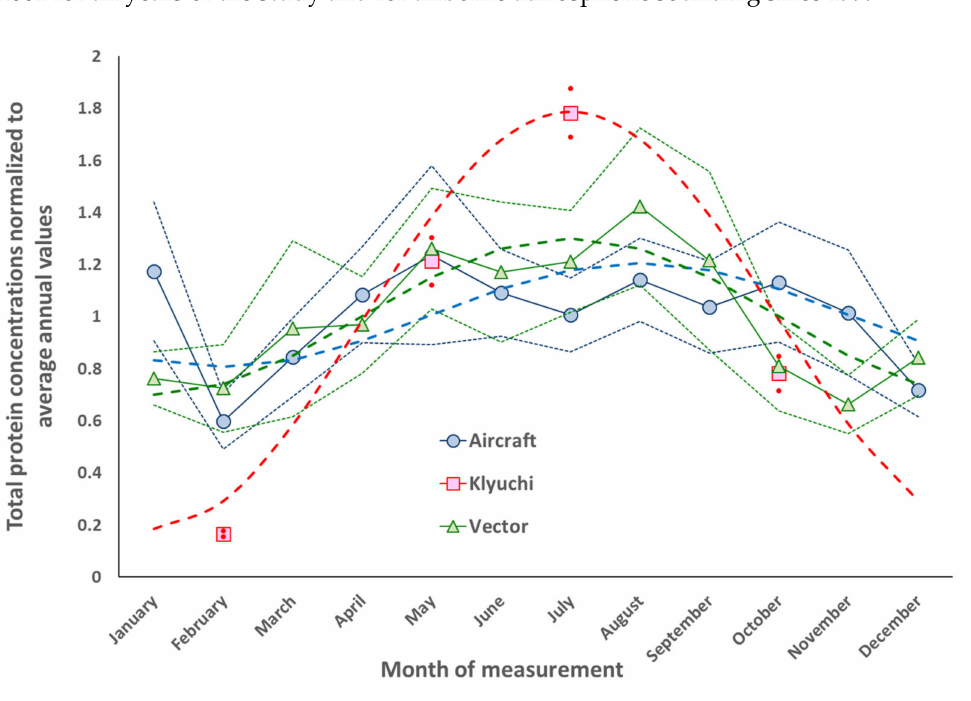
Figure 3. Dynamics of the normalized intra-annual concentration of total protein, measured at three locations near Novosibirsk. Explanations are in the